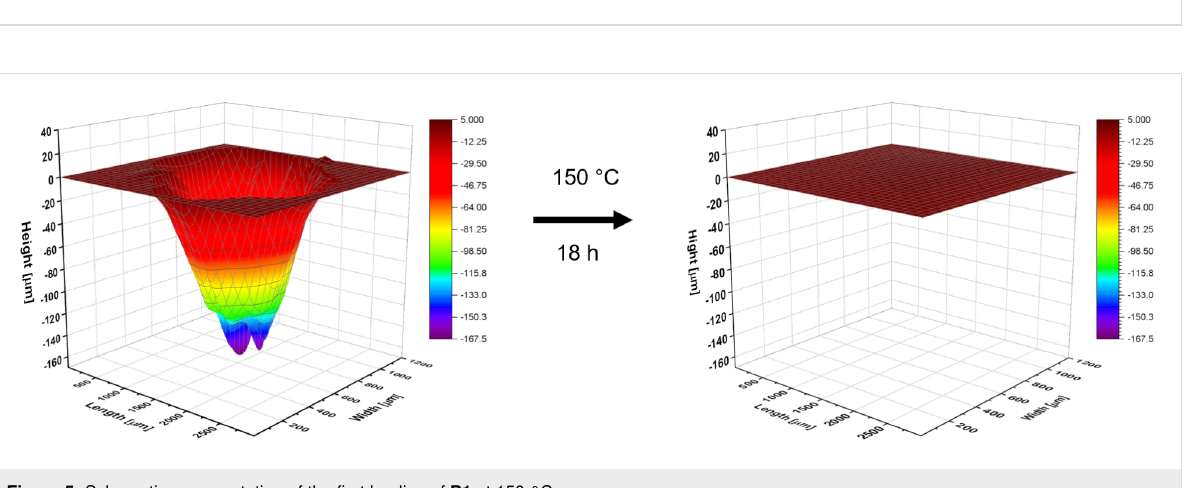
Figure 5: Schematic representation of the first healing of P1 at 150